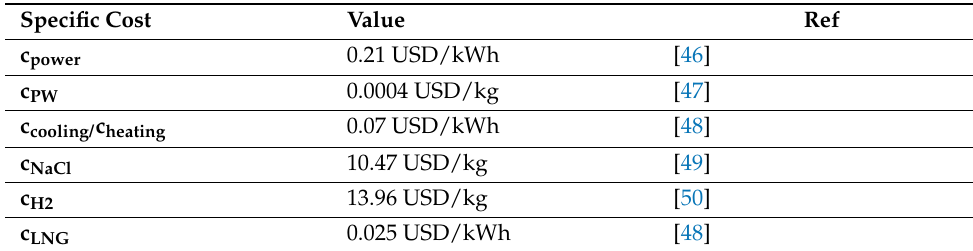
Table 6. The specific costs of fuel and products.